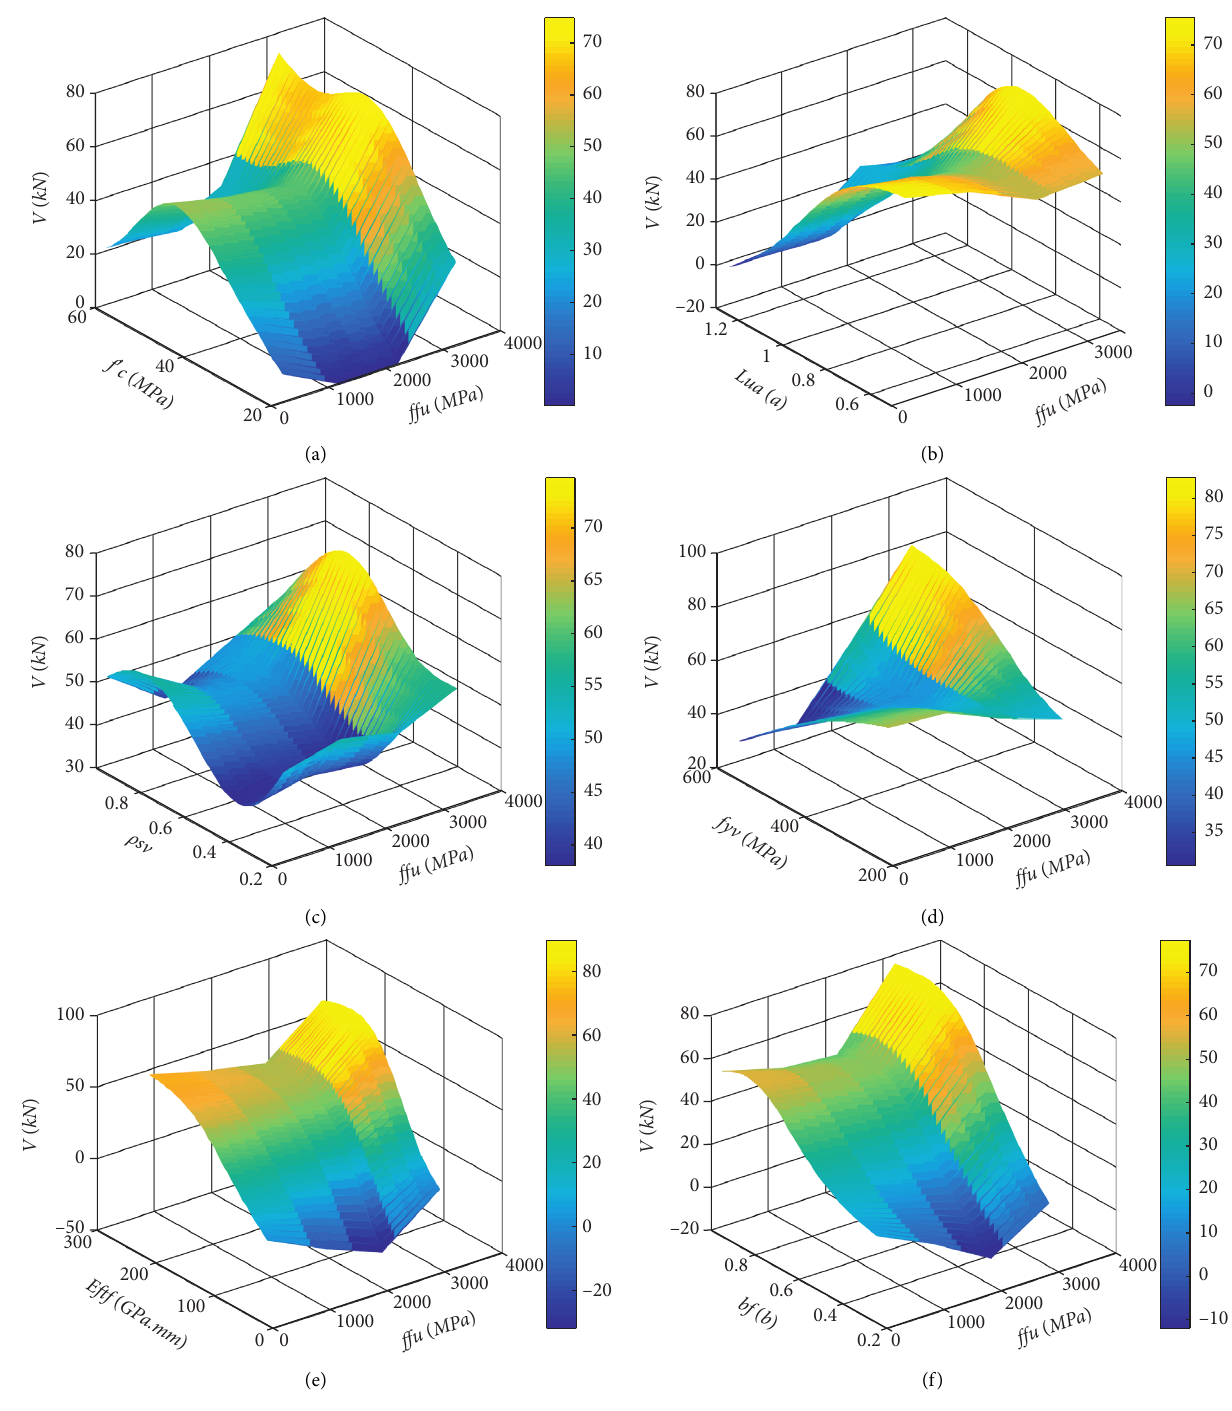
Figure 5: Sensitivity of each